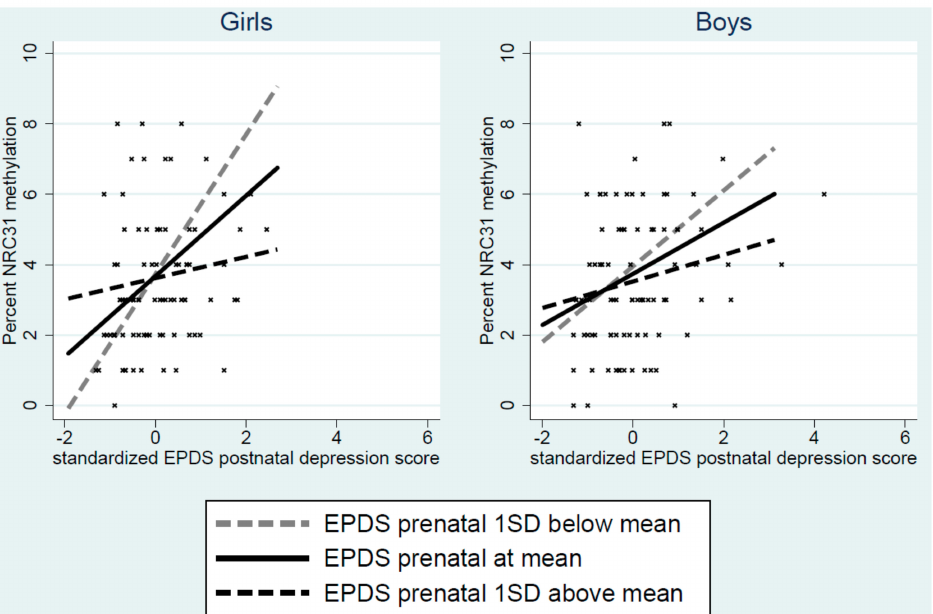
Figure 4. Regression lines for the interaction between pre- and post-natal depression and child NRC31 1-F promoter methylation, showing the e ff ect of postnatal depression at the mean and one standard deviation either side of the mean. The figure also shows a scatterplot of the